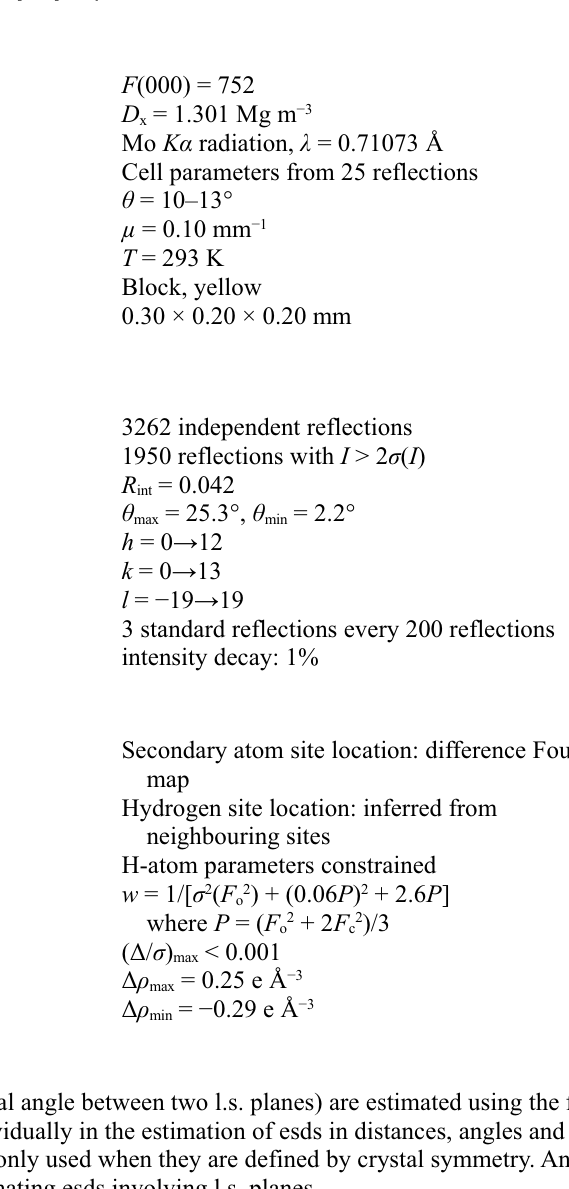
Figure 1 The molecular structure of (I) showing 50% displacement ellipsoids for the non-hydrogen atoms. Methyl